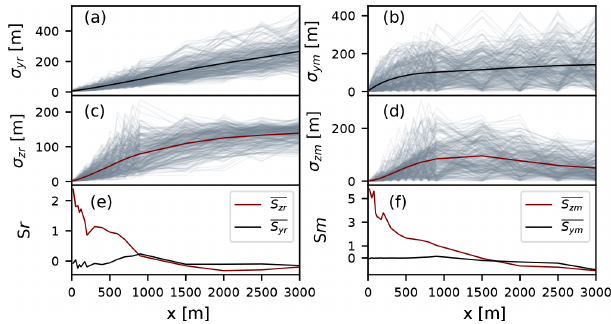
Figure 11. The second- and third-order moments of the simulated plume for the relative (a, c, e) components centered around the mean plume position and for the meandering (b, d, f) components. The first two panels in a row show the plume width in the y and z directions. All values are shown as functions of downwind distance. In gray are shown values of instantaneous plumes while their mean values are shown as solid black and red lines in y and z directions, respectively. The last panel shows skewness of the mean relative plume position as a function of distance from the